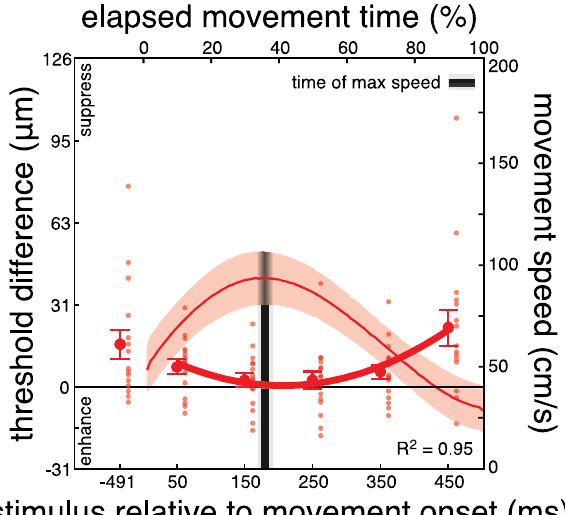
Figure 2. Results of Experiment 1. Differences in detection thresholds between baseline and reaching blocks across all 16 participants for each probing moment relative to movement onset (lower x-axis and left y-axis). Positive values along the left y-axis represent somatosensory suppression during movement, while zero represents no difference from baseline. Somatosensory processing is hampered on most times during the trial. However, it is similar to baseline around the time of maximal speed, moment which is illustrated with the black vertical line (gradient showing SD across participants). Large symbols show average values across participants along with their standard error and small dots represent individual participants. The thick red line represents a quadratic function fit to the participants’ average data. The time-normalized averaged movement speed is superimposed (upper x-axis and right y-axis), with standard deviation across participants (red shaded